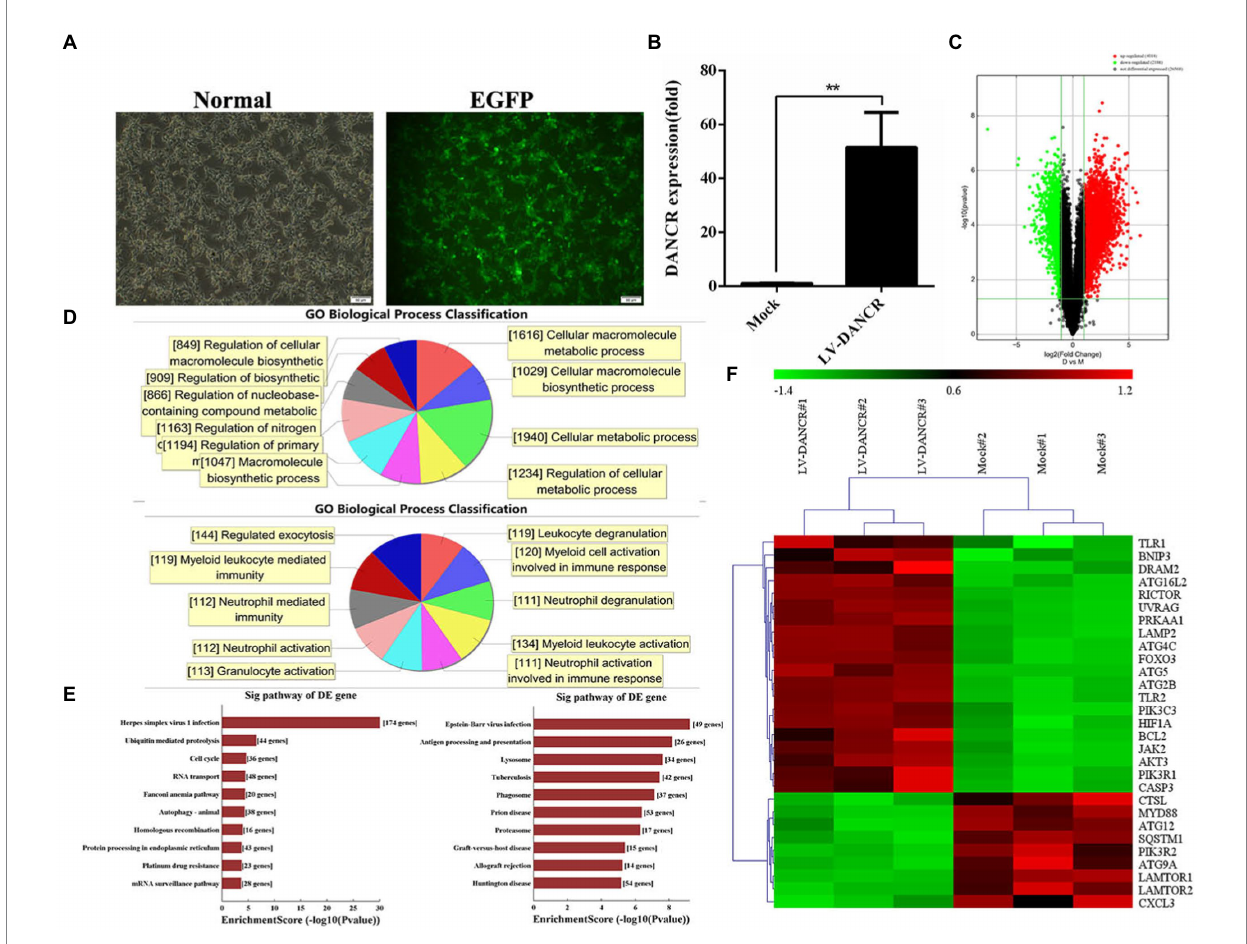
FIGURE 3 Bioinformatics analysis of DANCR overexpression. (A) THP-1 cells were transfected with lentivirus encoding DANCR overexpression plasmid for 3 days and further treated with puromycin to construct lentivirus (LV)-DANCR cells (green fluorescent protein-positive). The images showed the PMA-treated LV-DANCR cells at a magnification of 200. (B) The quantity of DANCR in LV-DANCR cells was confirmed via qRT-PCR. Data represent the mean ± SD from three replications. A two-tailed Student’s t -test was used for statistical analysis. ** p < 0.001. (C) The LV-DANCR cells were detected by whole human genome oligo microarray, and the differential probe signal of mRNAs was screened using value of p and the FDR method and exhibited as volcano map (fold change ≥ 2.0, value of p ≤ 0.05, FDR ≤ 0.05). The red dots represented the elevated genes, and the green dots stood for descending genes. (D) The differential mRNAs in LV-DANCR cells compared to normal THP-1 cells were identified and annotated with gene ontology (GO). The most enriched biological process terms of elevated mRNAs (upper panel) and decreasing mRNAs (bottom panel) were drew by computation. (E) A Kyoto Encyclopedia of Genes and Genomes (KEGG) analysis was performed to enrich differential expressed mRNAs in LV-DANCR cells. The elevated mRNAs (left) and the decreased mRNAs (right) were grouped with identical pathway terms and sorted by numbers. (F) The genes that were highly associated with autophagy were identified by GO annotation and KEGG analysis in advance and then clustered for revealing similar biological properties in two groups. (lane 1–3: LV-DANCR cells, lane 4–6: normal THP-1